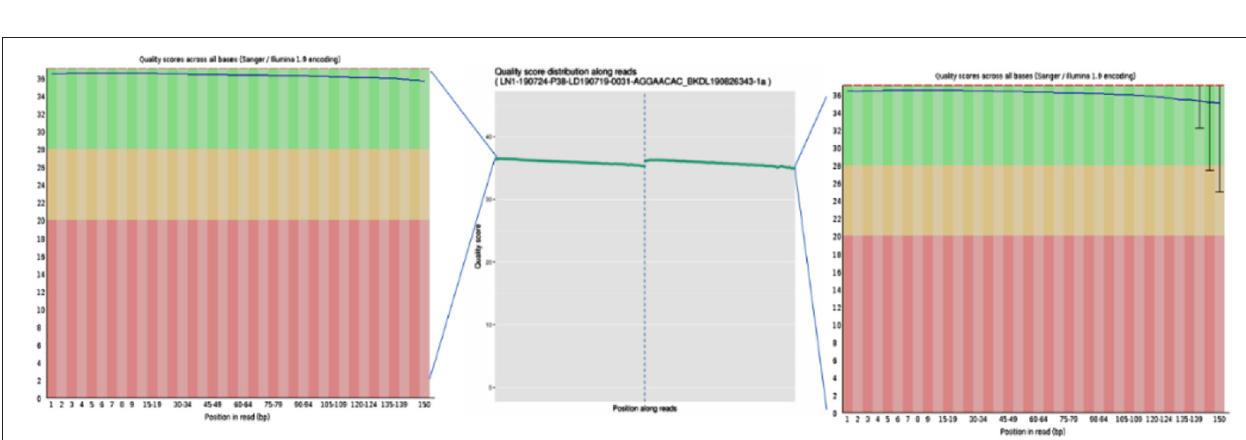
FIGURE 2 | Base quality values of sequencing data from the Illumina sequencing platforms. Quality values are represented by Qphred, where Qphred = − 10 × log 10 (e), with e representing the base sequencing error rate. The corresponding relationship between base recognition error rate and Phred score in Illumina Base Calling software is as follows: when Phred score is 10, the base correct recognition rate is 90%; when the Q-score is Q10 and Phred score is 20, the correct base identification rate is 99%; when the Q-score is Q20 and Phred score is 30, the correct base recognition rate is 99.9%; when the Q-score is Q30 and Phred score is 40, the correct base recognition rate is 99.99%; and when the Q-score is Q40, the correct base identification rate is 99.99%. The abscissa represents the position of the base, the ordinate represents the quality of the base at each position, the left graph represents the data before quality control, and the right graph represents after quality control.